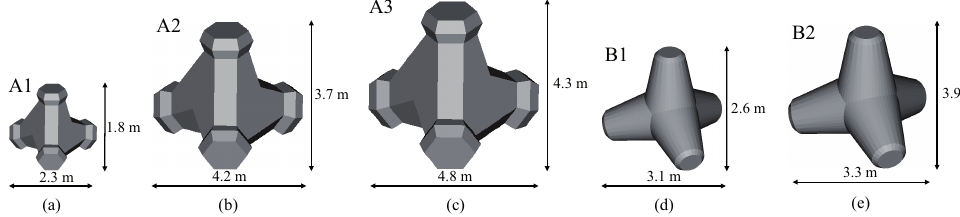
Figure 9. Triangular mesh models of wave-dissipating blocks are used in this study. We named these blocks Block A1 ( a ), Block A2 ( b ), Block A3 ( c ), Block B1 ( d ) and Block B2 ( e ). They are made of concrete to dissipate the force of waves. Notably, A1, A2, and A3 have the same shape but different sizes, and so do B1 and B2.